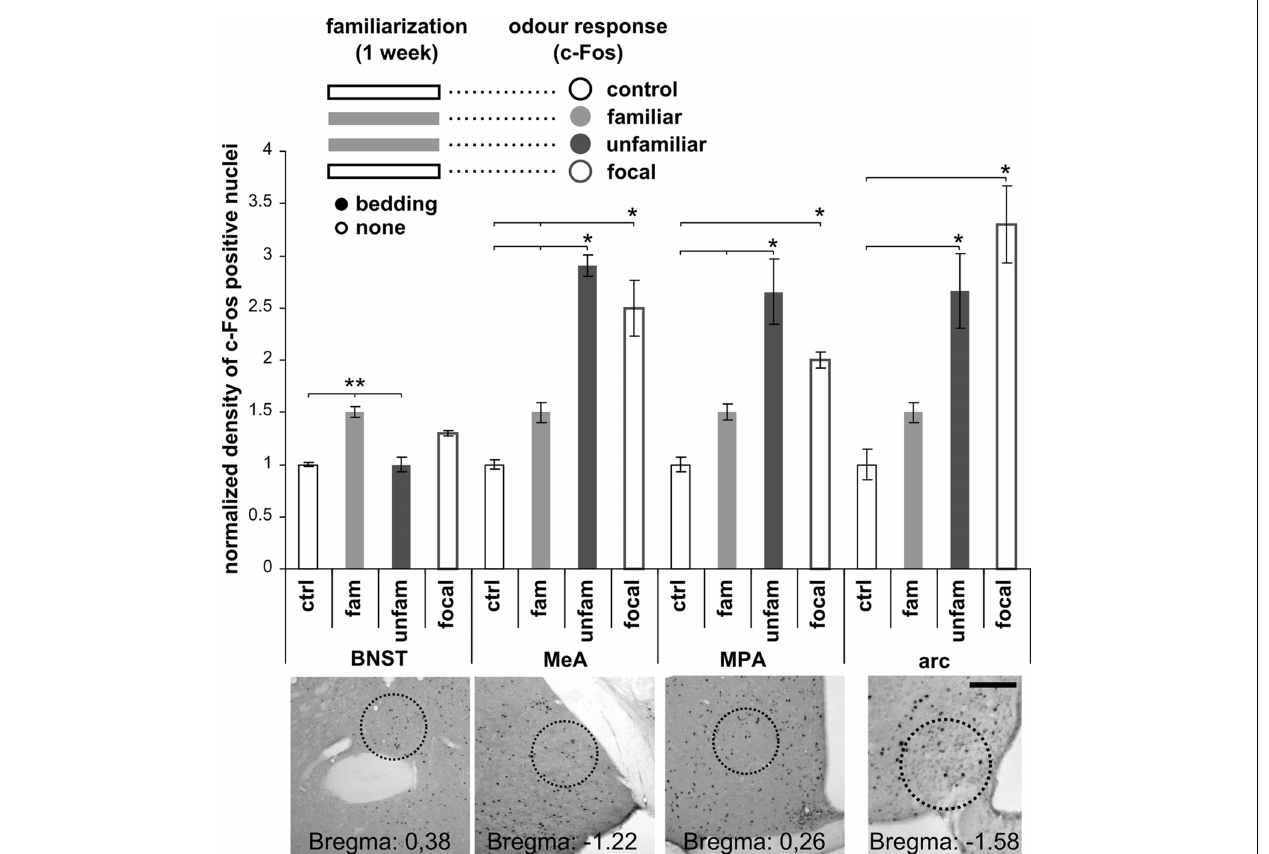
male (unfamiliar, dark-gray). Another group of females has been exposed to male individual odors with no prior experience of male derived stimuli (focal, lined gray). As shown in the graph, novel odors (unfamiliar or focal) induce strong activity in the MeA, MPA, and arc, while familiar odors (light-gray) do not. Radius of sampled areas: 75 μ m. Scale bar: 100 μ m. Data are normalized means ± SEM, * P < 0.05, ** P <